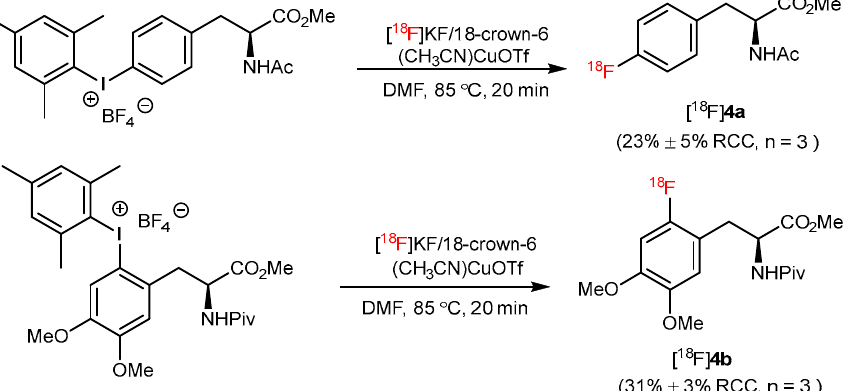
Figure 4. Synthesis of [ 18 F] 4a and [ 18 F] 4b through (mesityl)(aryl)iodonium salts. Modified from Ichiishi et al.